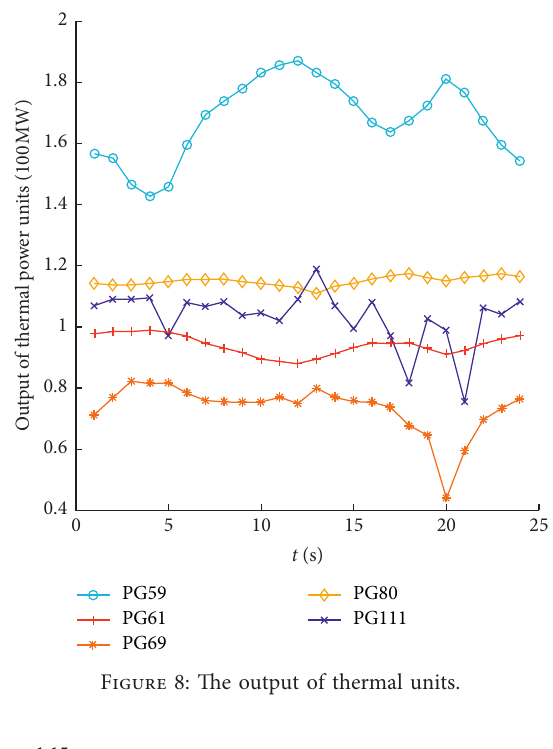
Figure 8: The output of thermal